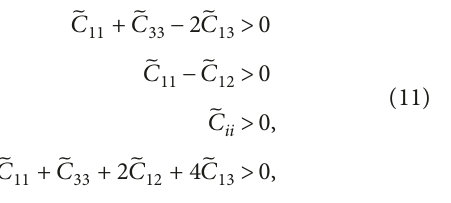
P as a function of pressure for LiFeAs and